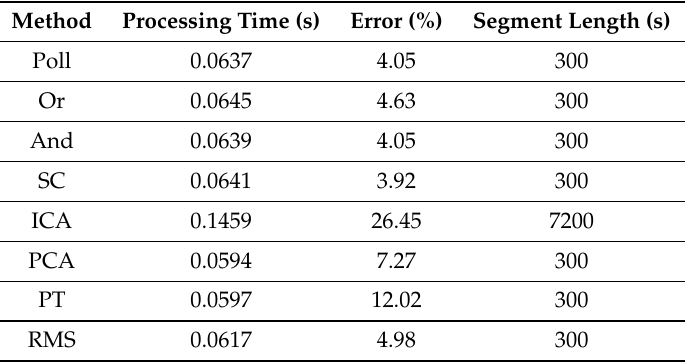
Table 3. Optimal segment lengths, processing time per segment, and detection error for each proposed method in vPREDICT database.